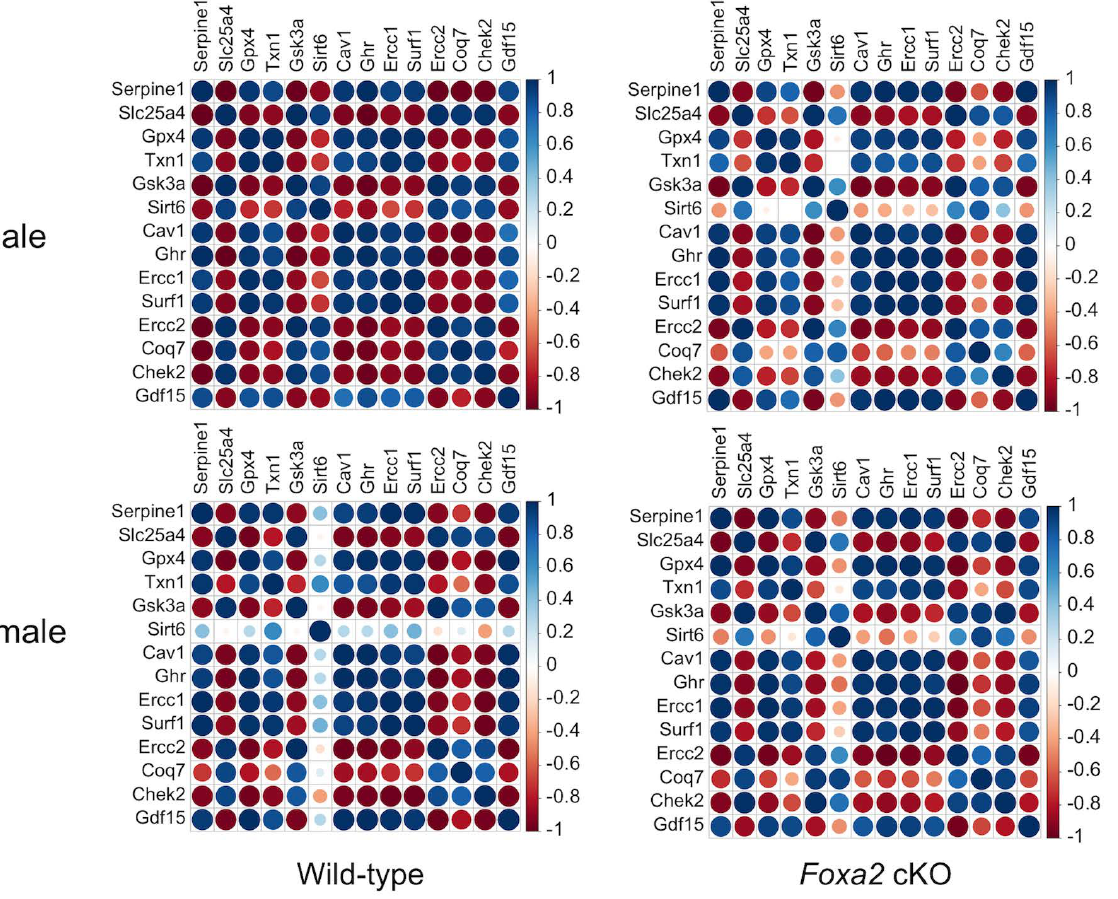
Figure 4. Correlation plots showing expression of Sirt6 relative to the expression of other longevity genes in the WT versus cKO mice of both sexes (sample size: n = 24). The color-coded scale of correlation levels is shown on the right to each